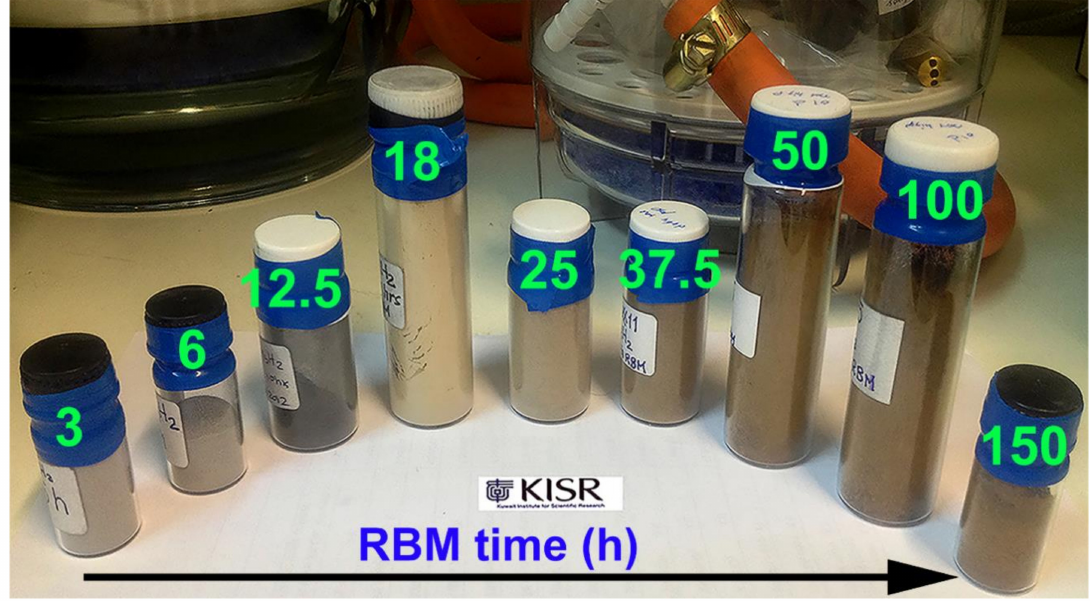
Figure 10. As—cold rolled Mg—shots milled for di ff erent RBM time (3, 6, 12.5, 18, 25, 37.5, 50, 100, and 150 h). The significant e ff ect of RBM time on the samples’ color is